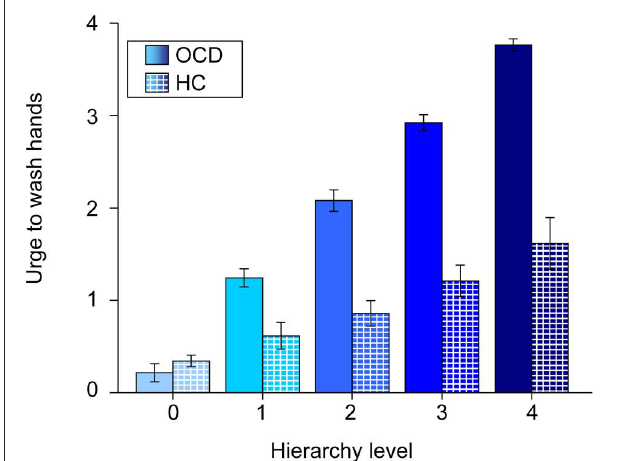
FIGURE 4 | Mean urge to wash hands (and standard errors of the mean) of patients (solid colors) and healthy controls (patterned) for individualized pictures plotted against hierarchy levels. Note that values of healthy controls are plotted against the original hierarchy level values of their respective matching partners. The different shades of blue represent the different original hierarchy level values (cp. Figure 1 ).